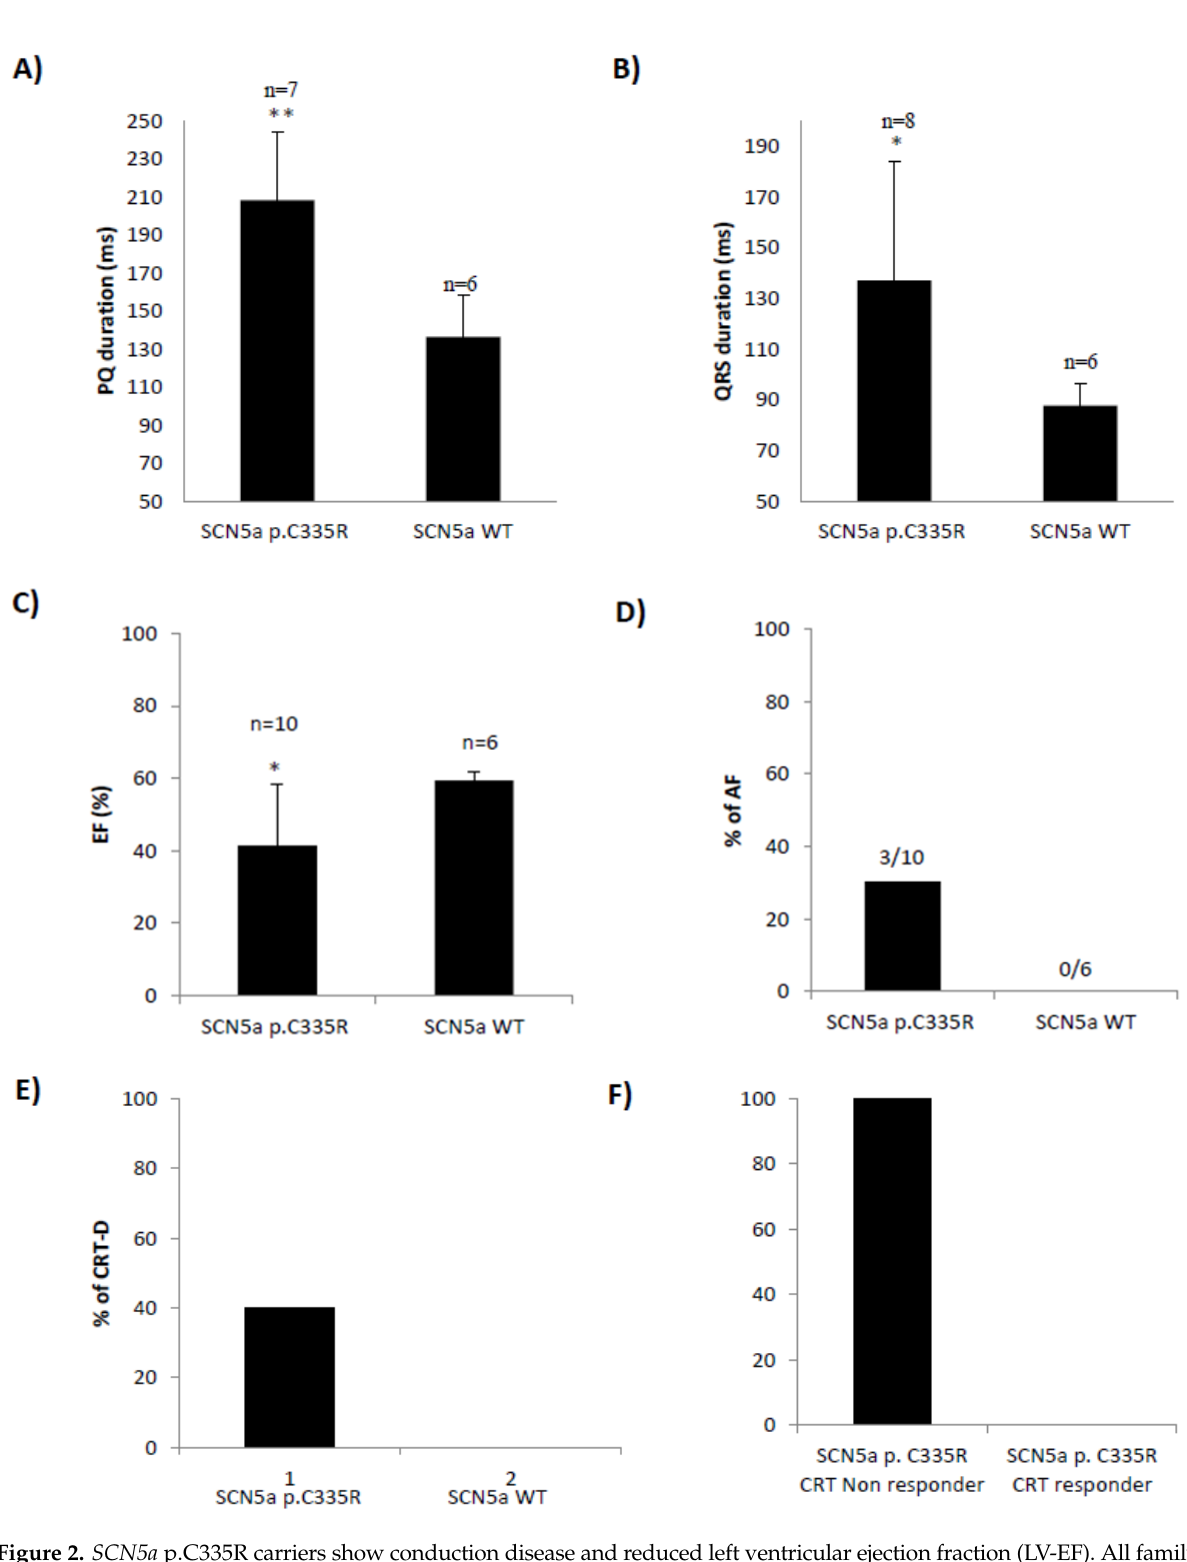
Figure 2. SCN5a p.C335R carriers show conduction disease and reduced left ventricular ejection fraction (LV-EF). All family members with SCN5a p.C335R variant showed significantly longer PQ ( A ) and QRS intervals ( B ), lower left ventricular EF ( C ), and higher atrial fibrillation (AF) rates ( D ) than other family members without this variant. All 4 family members carrying SCN5a p.C335R who received CRT-D were non-responders ( E , F ). T-Test; * = p ≤ 0.05, ** = p ≤ 0.01. Data are presented as mean ±